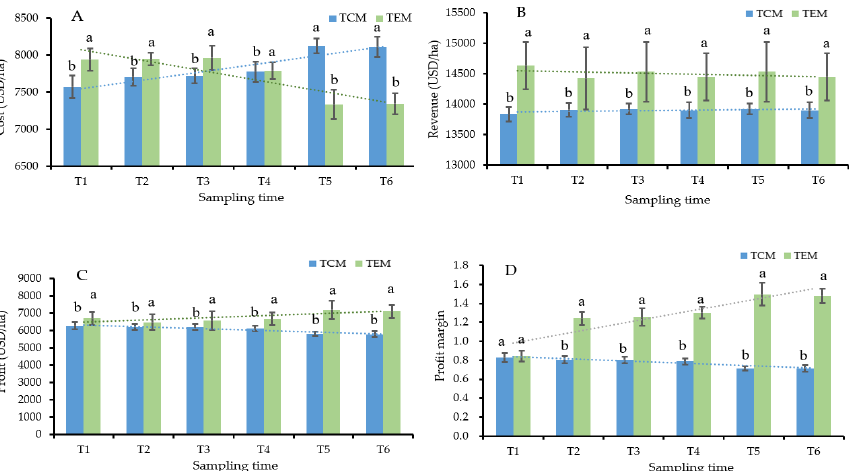
Figure 6. The effects of management mode on the economic benefits. The different letters labeled in columns are significantly different according to Duncan’s test ( p < 0.05). ( A ) Cost, ( B ) revenue, ( C ) profit, and ( D ) profit margin. TCM = tea conventional management; TEM = tea ecological management. T1 = spring 2016; T2 = autumn 2016; T3 = spring 2017; T4 = autumn 2017; T5 = spring 2018; T6 = autumn